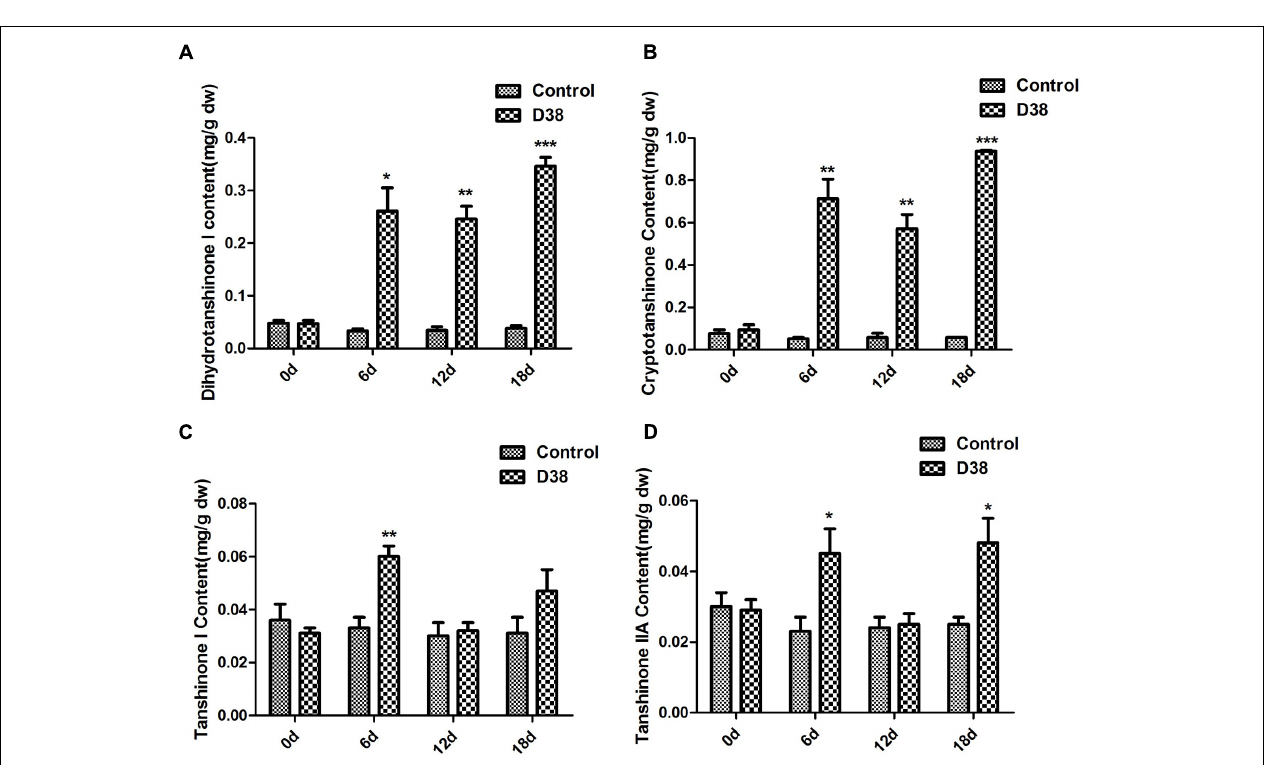
FIGURE 3 | The effect of D38 hyphae on the contents of tanshinones of S. miltiorrhiza hairy roots. (A) Dihydrotanshinone I content; (B) Cryptotanshinone content; (C) Tanshinone I content; (D) Tanshinone IIA content. Values are presented as means ± SD, n = 3. ∗ p < 0.05; ∗∗ p < 0.01; ∗∗∗ p < 0.001 versus the control culture.